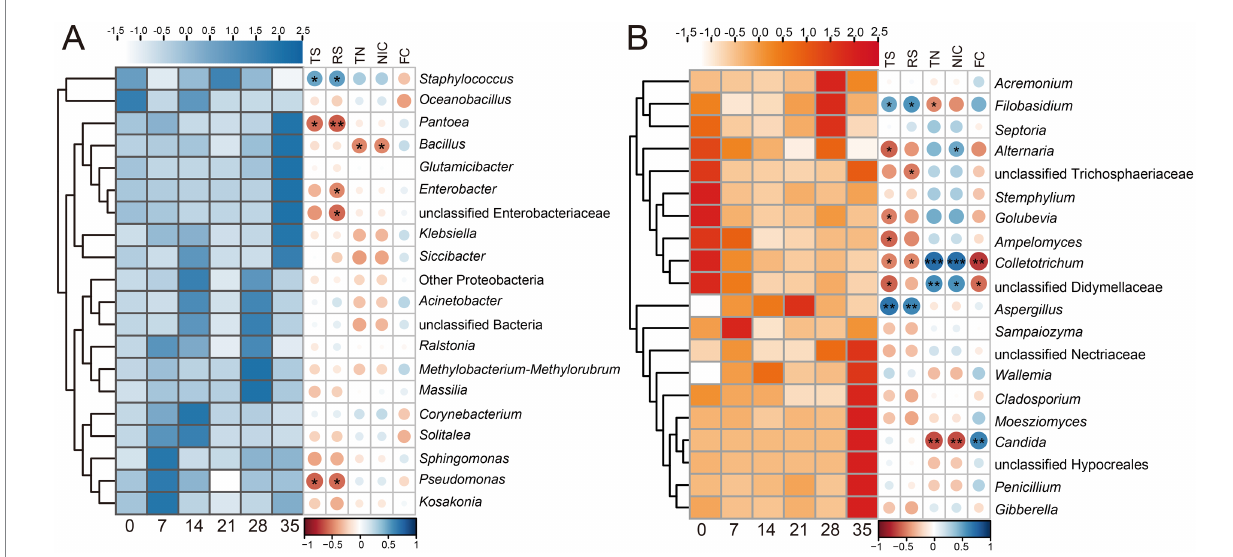
FIGURE 3 Heatmaps showing the succession of Top20 genera and the correlations between each genus and fermentation indicators during cigar fermentation. (A) Bacteria; (B) fungi. The relative abundance of each microbial genus was normalized using Z-score. Succession in microbial genera is shown on the left, color is positively correlated with relative abundance. The right side shows the Spearman correlation between each genus and fermentation indicators, the correlation coefficient is represented by the color and size of the circles, dark blue indicates positive correlation, and dark red indicates negative correlation. * p < 0.05; ** p < 0.01; *** p < 0.001. TS, total sugar; RS, reducing sugar; TN, total nitrogen; NIC, alkaloid. The numbers 0, 7, 14, 21, 28, 35 indicated the fermentation days.